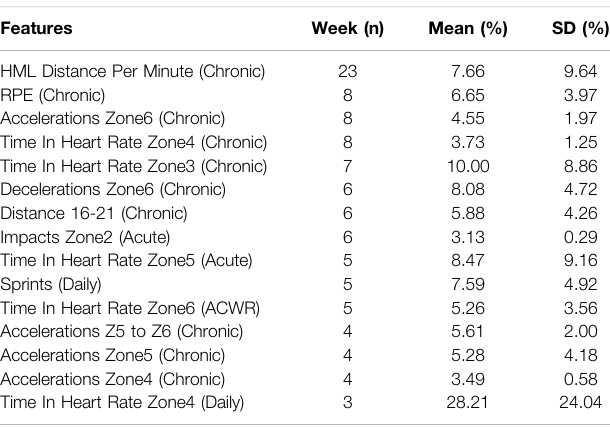
TABLE 7 | Feature importance of real